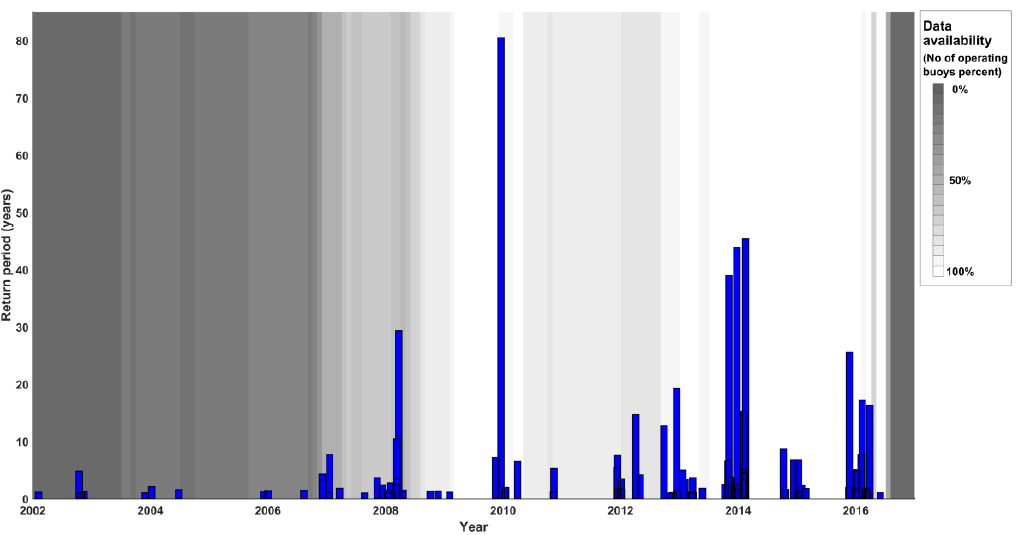
Figure 3. Maximum return period per event plotted against occurrence date. The grey color of the background represents the percentage of number of sites recording: the lighter the grey, the more data are available.